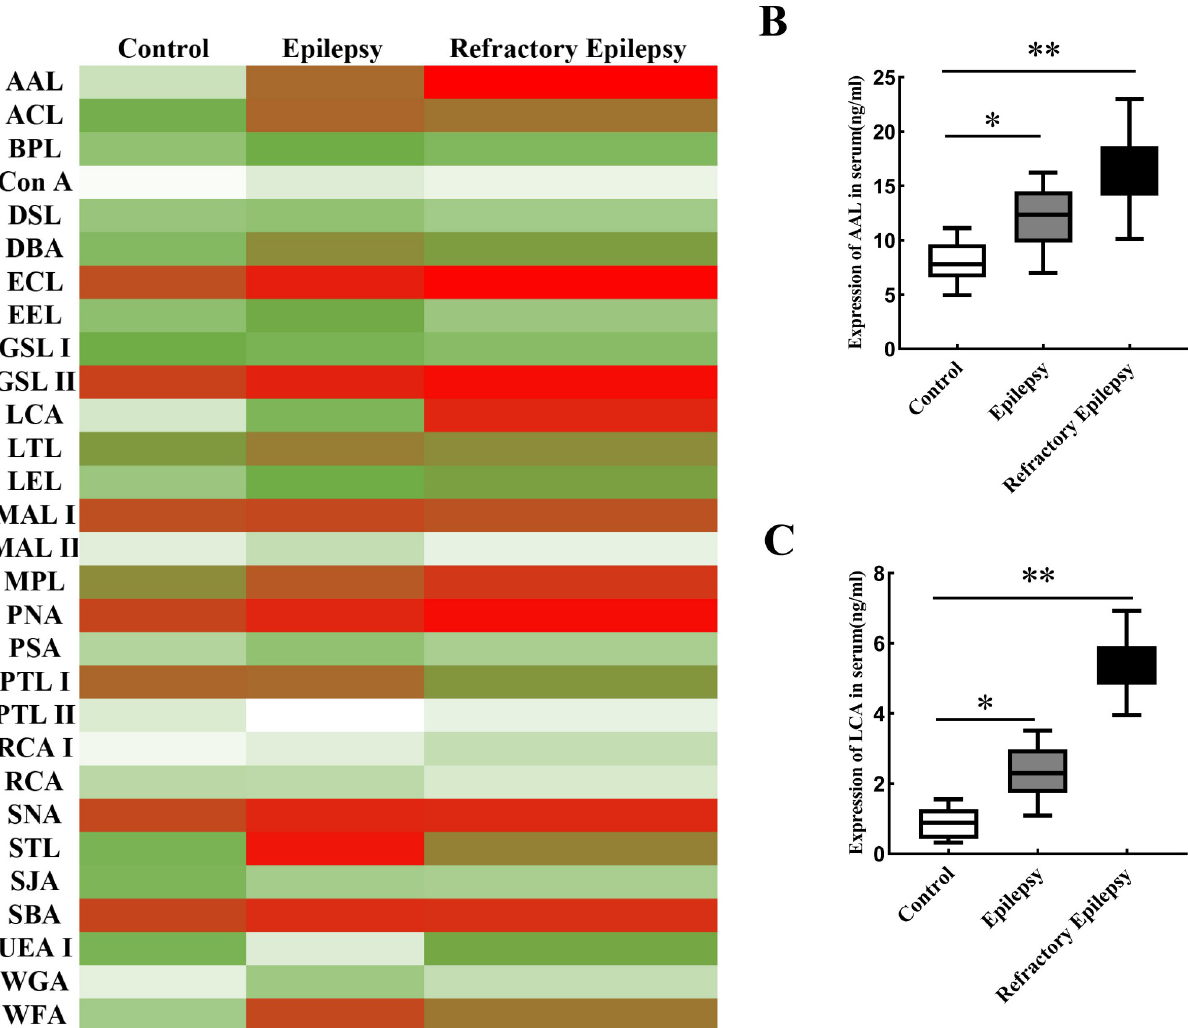
Fig 2. Changes in the expression of lectins in the patient’s serum. A . Changes of lectins were examined by lectin chip. B . ELISA was used to detect AAL expression. C. ELISA was used to detect LCA expression. * indicated p < 0.05, ** indicated p <